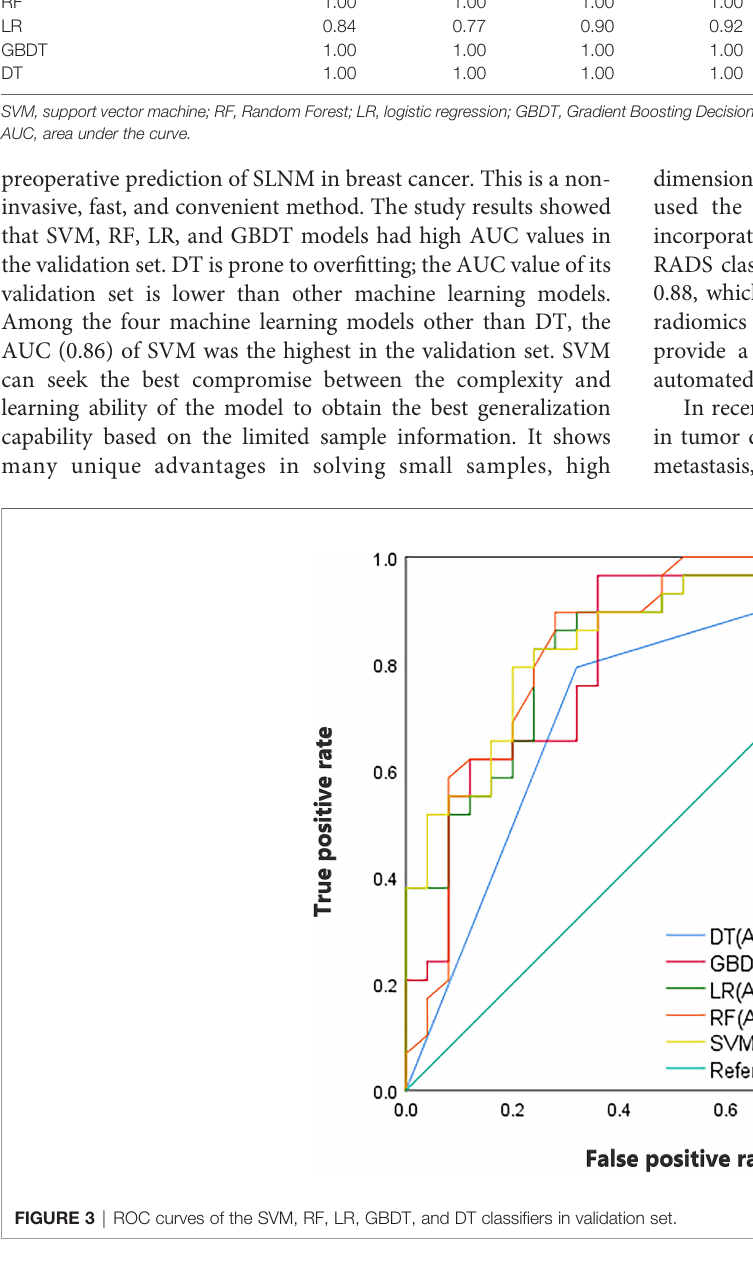
TABLE 3 | Prediction performance of training and validation sets of the combined model (SVM algorithm). Group ACC SEN AUC Training set